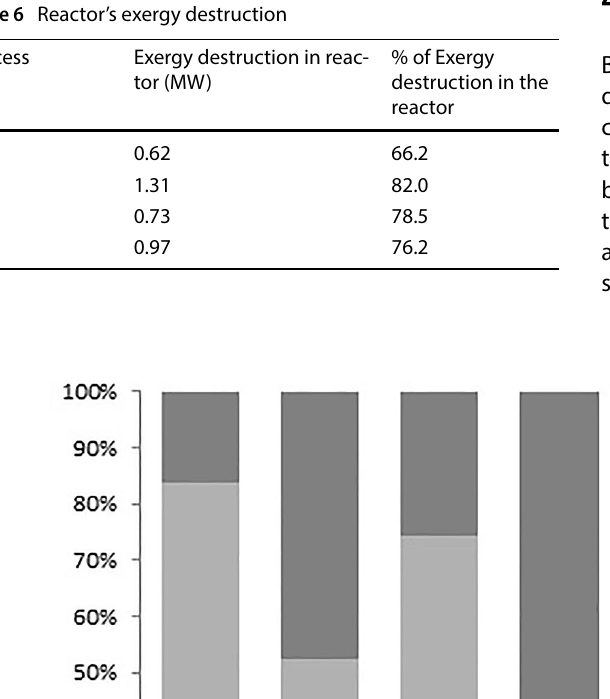
*Values regarding the calculation of the exergetic efficiency considering all of the byproducts of the process such as hydrocarbons, higher and lower